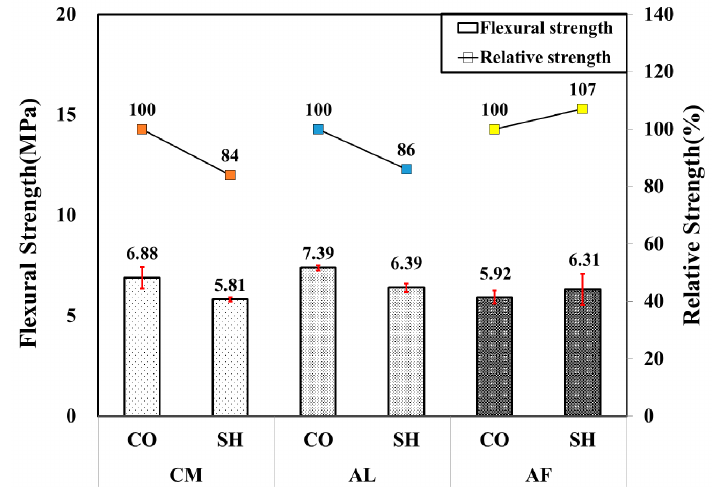
Figure 8. Flexural strength by accelerators for 1-month-old specimens.